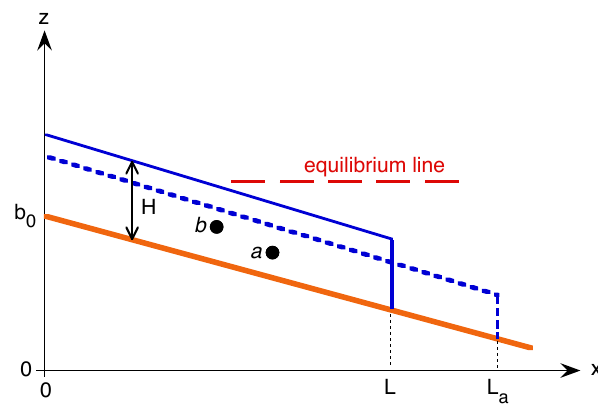
Fig. 2. Simple geometry for the glacier model used in this study (solid line). The dashed profile represents the geometry after a surge. The centres of gravity before ( b) and after ( a) the surge are indicated by black dots.